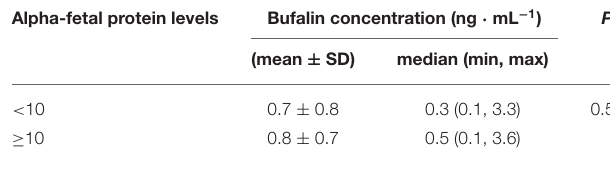
TABLE 3 | The relationship between endogenous bufalin and alpha-fetal protein levels in HCC